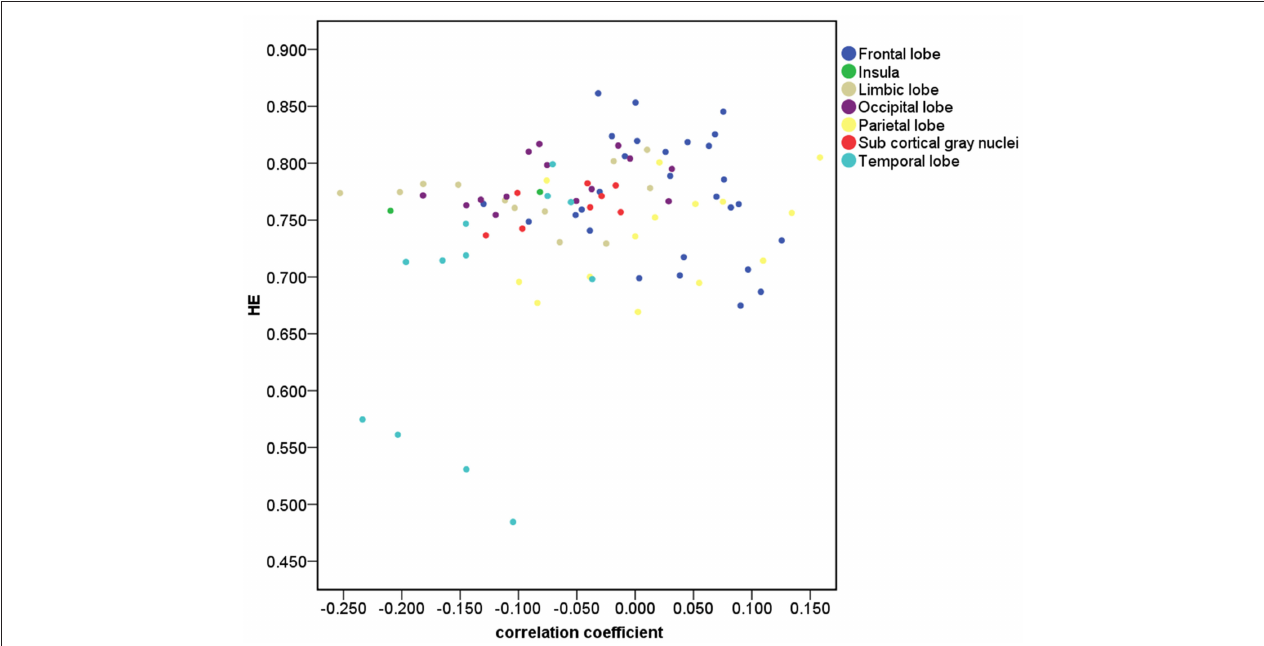
FIGURE 2 | Correlation for the 90 brain regions between HE and age. The brain gray matter was subdivided into 7 lobar regions based on the 90 AAL regions.